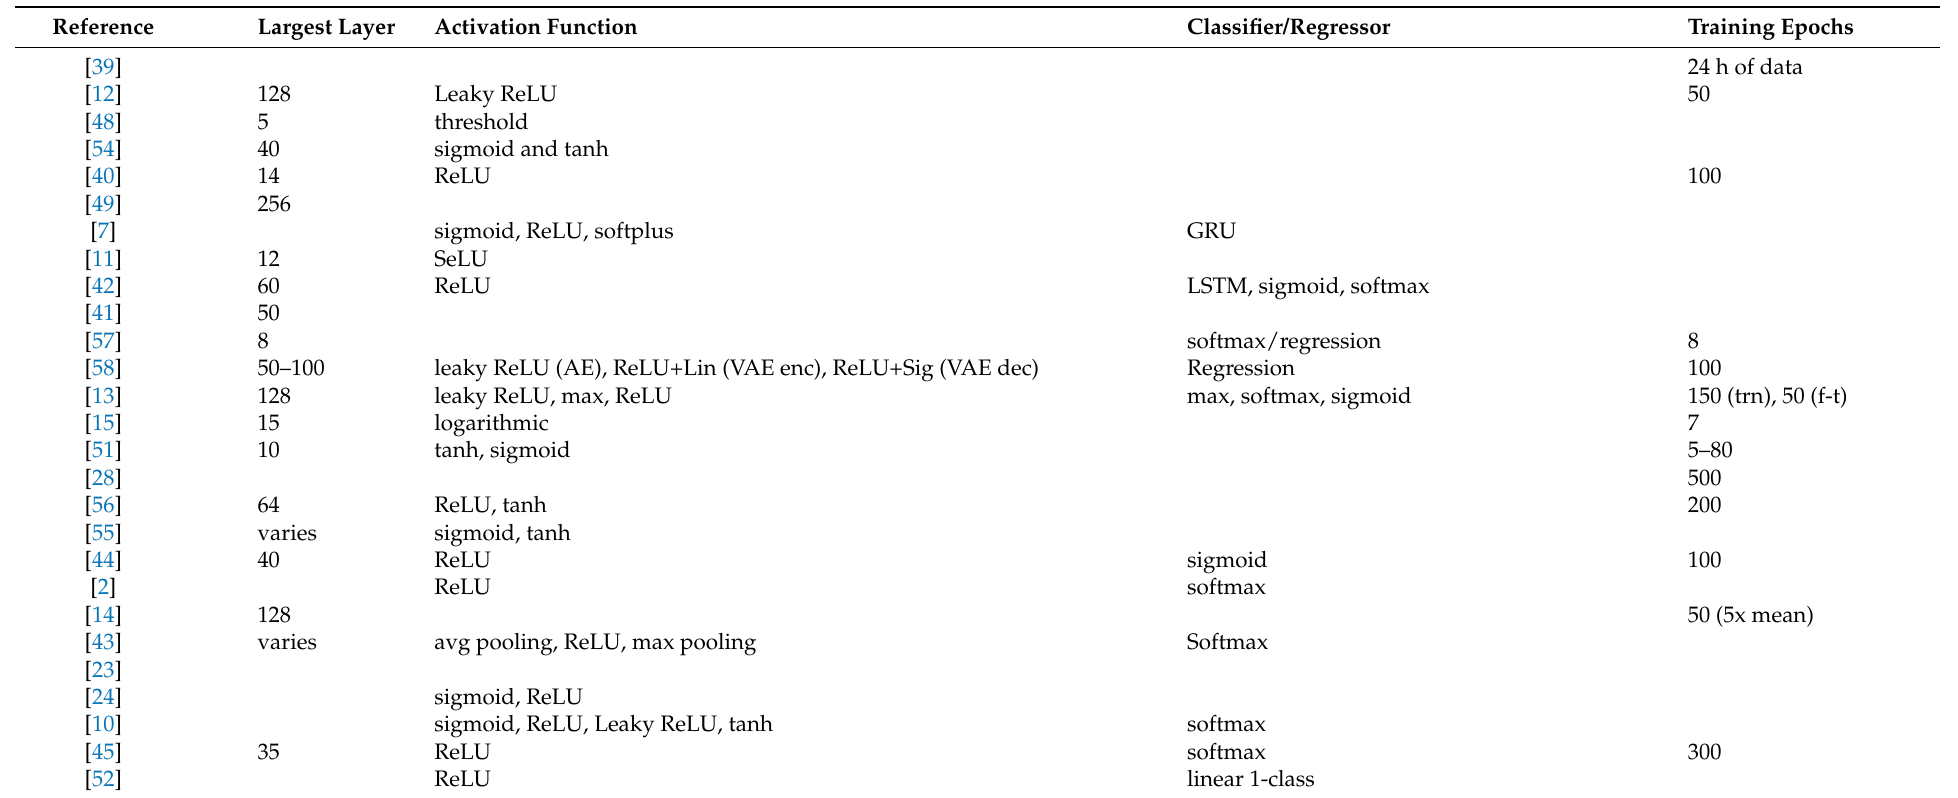
Table A2. Breakdown of hyperparameters in surveyed